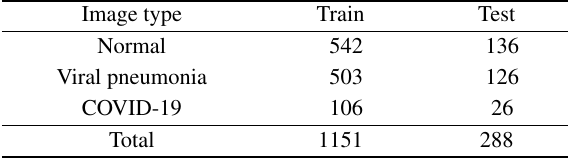
Table 2 Distribution of images in train and test sets.